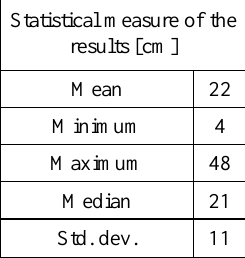
Table 2 . Statistical result of automatically founded corners compare to a manually created map of Barnag test